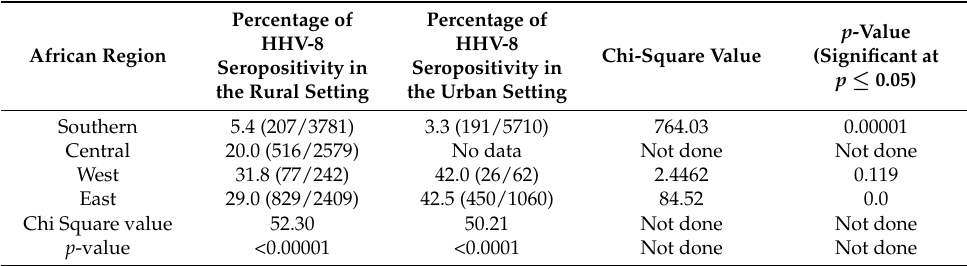
Table 3. Relative HHV-8 infection burden in rural and urban populations in